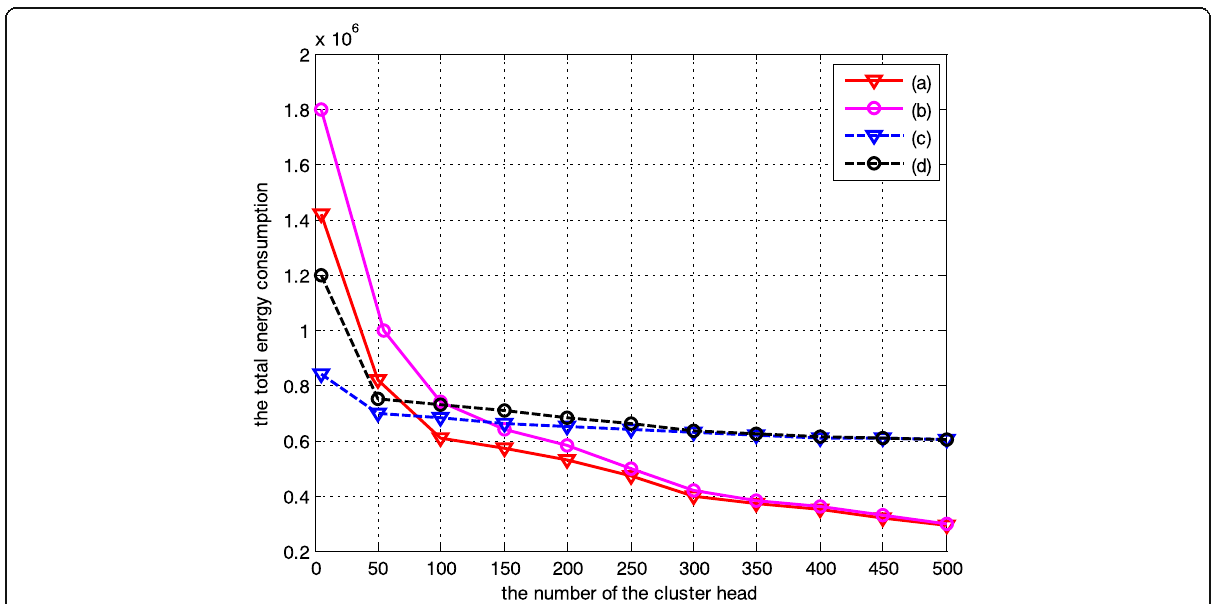
Fig. 11 Comparison of the total energy consumption of